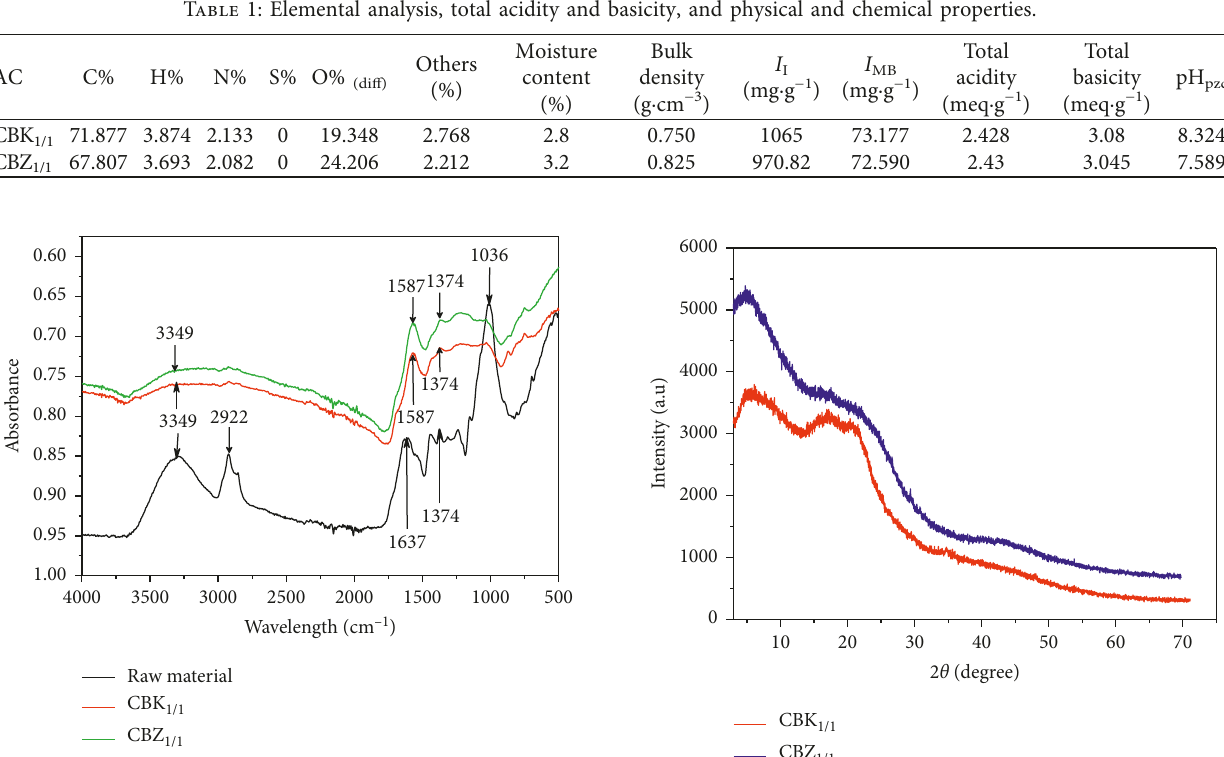
Figure 3: FTIR spectra of activated carbon (CBK and raw